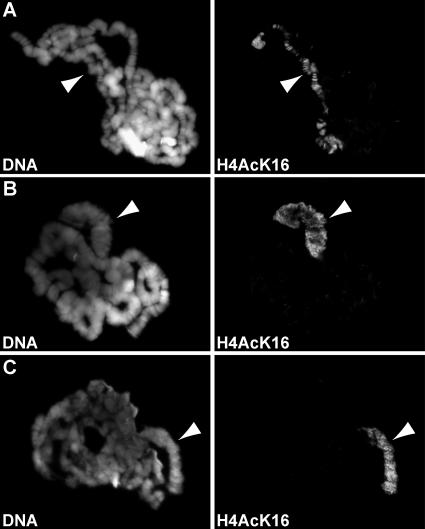
H4K16 Acetylation Is Not Affected by Loss of ISWISalivary gland polytene chromosomes from male third-instar larvae were stained with DAPI and an antibody that specifically recognizes acetylated H4K16 (H4AcK16). The male X chromosome is marked by arrowheads. The level of H4K16 acetylation on the X chromosome of wild-type (A) and Iswi1/Iswi2 (B) larvae is similar. Chromosome decondensation resulting from the expression of ISWIK159R in salivary gland nuclei is not due to the spread of H4K16 acetylation to the autosomes (C). All three images were captured using identical exposure times.